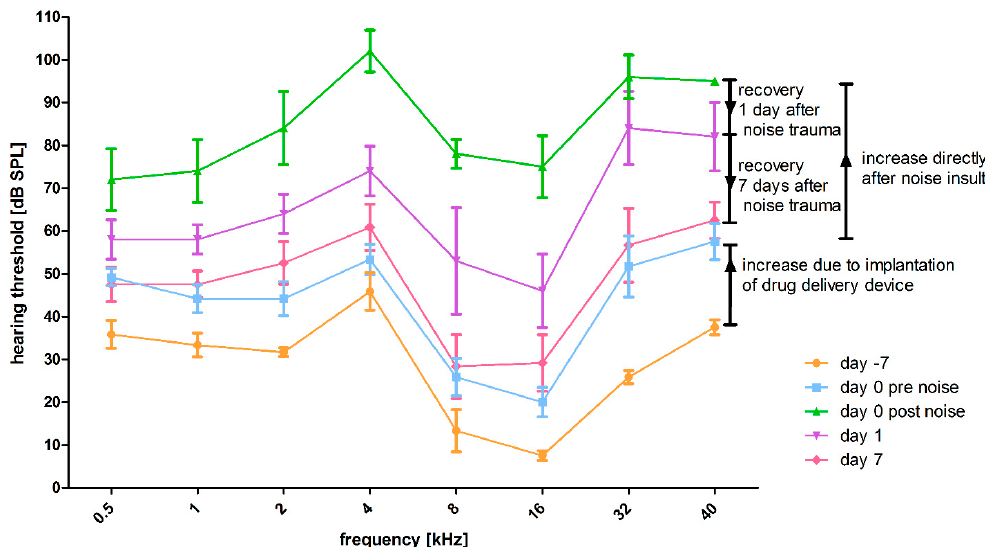
Figure 10. Effect of noise exposure on ABR pure tone thresholds in implanted ears over time. Mean frequency ‐ specific hearing thresholds of the left (implanted and noise affected) ears are illustrated with standard deviation. Where the hearing threshold could not be identified up to the maximum sound stimulus level of 100 dB SPL (85 dB SPL for 40 kHz), the threshold was defined as 110 dB SPL or 95 dB SPL for 40 kHz. Day − 7 is displayed in orange, day 0 before noise trauma in blue, day 0 post noise trauma in green, day 1 in purple and day 7 in pink.